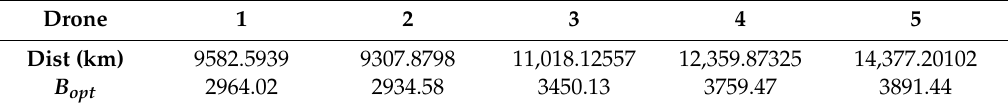
Table 3. The calculated values of distance and 𝐵 𝑜𝑝𝑡 attained after the first iteration.